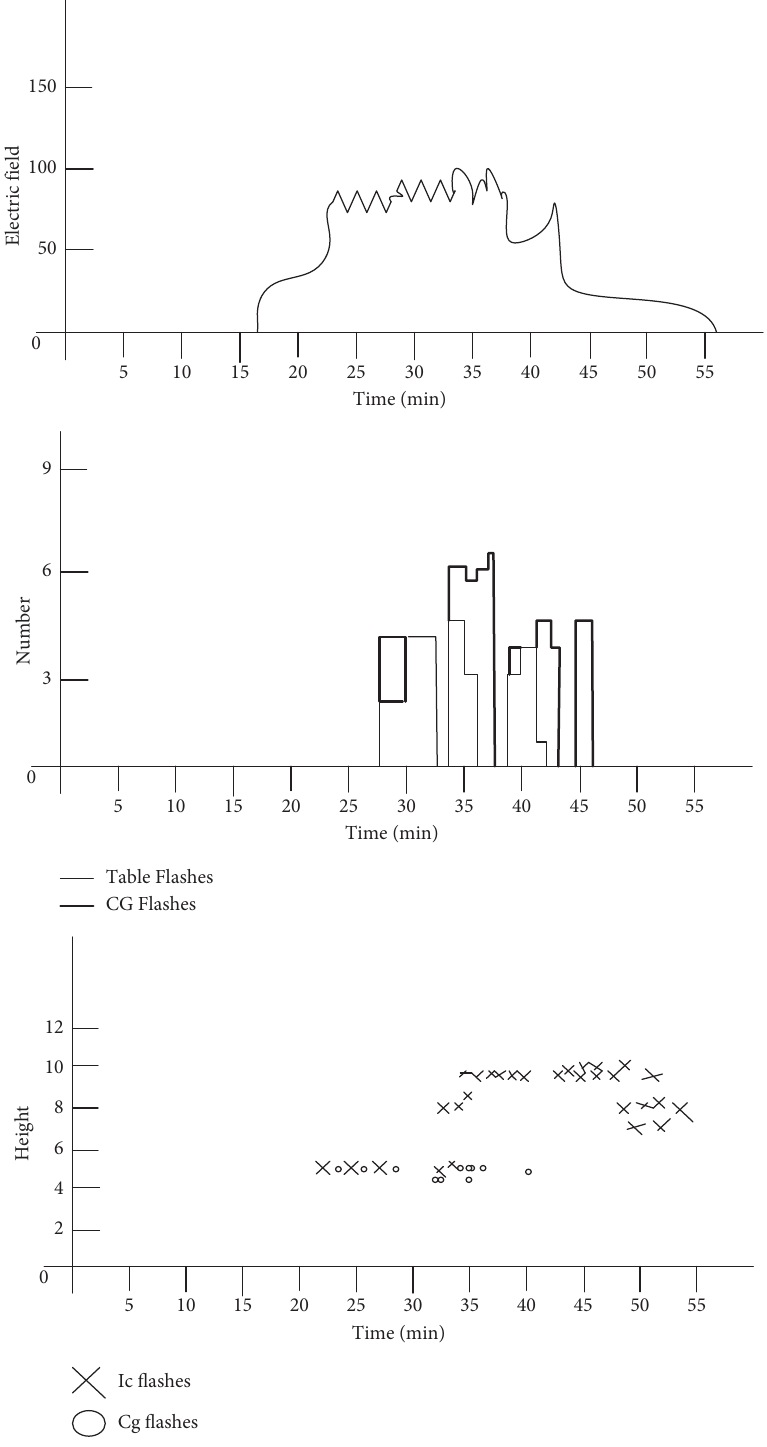
Figure 9: Evolution of some parameters during the